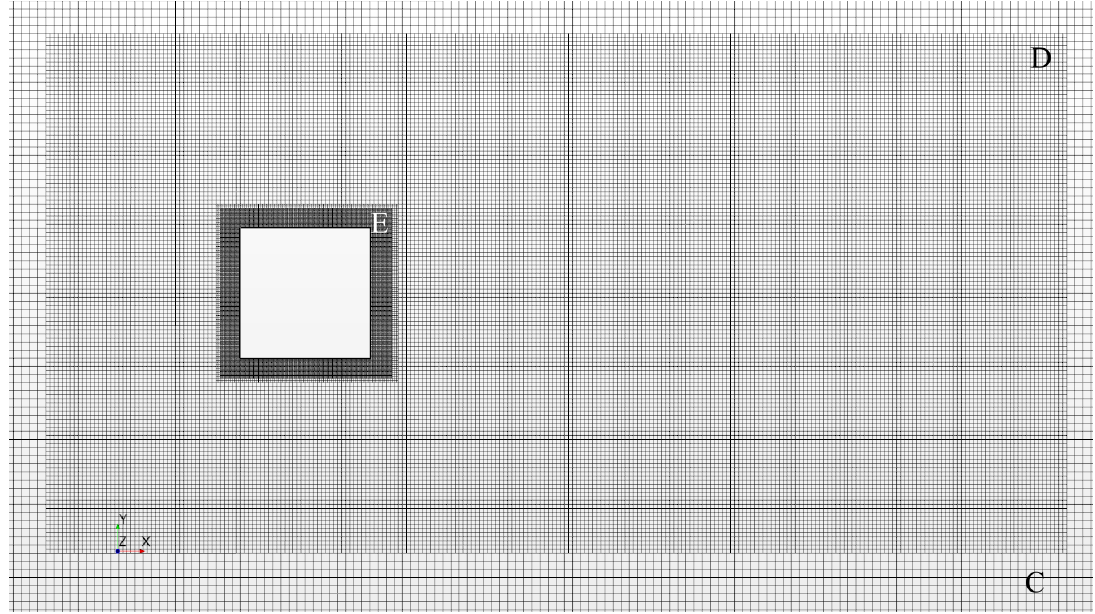
Figure 5. Near body mesh viewed at cylinder center line.